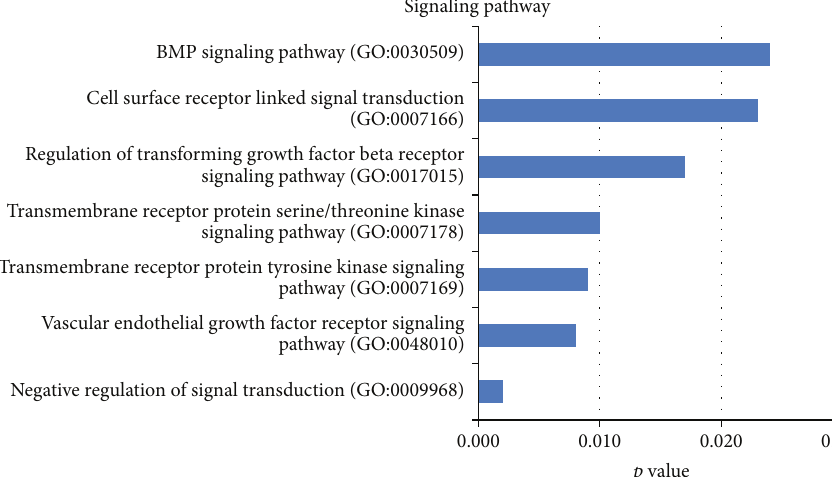
Table 2: Gene pathways based on the KEGG classification of an increased expression in CD 34 − stem cells from umbilical cord blood. KEGGID 𝑝 value Odds ratio Exp. count Count Size Term 4060 0.001 2.947 14 33 223 Cytokine-cytokine receptor interaction 4620 0.001 3.672 92 Toll-like receptor signaling pathway 5120 0.001 0.012 130 JAK-STAT signaling